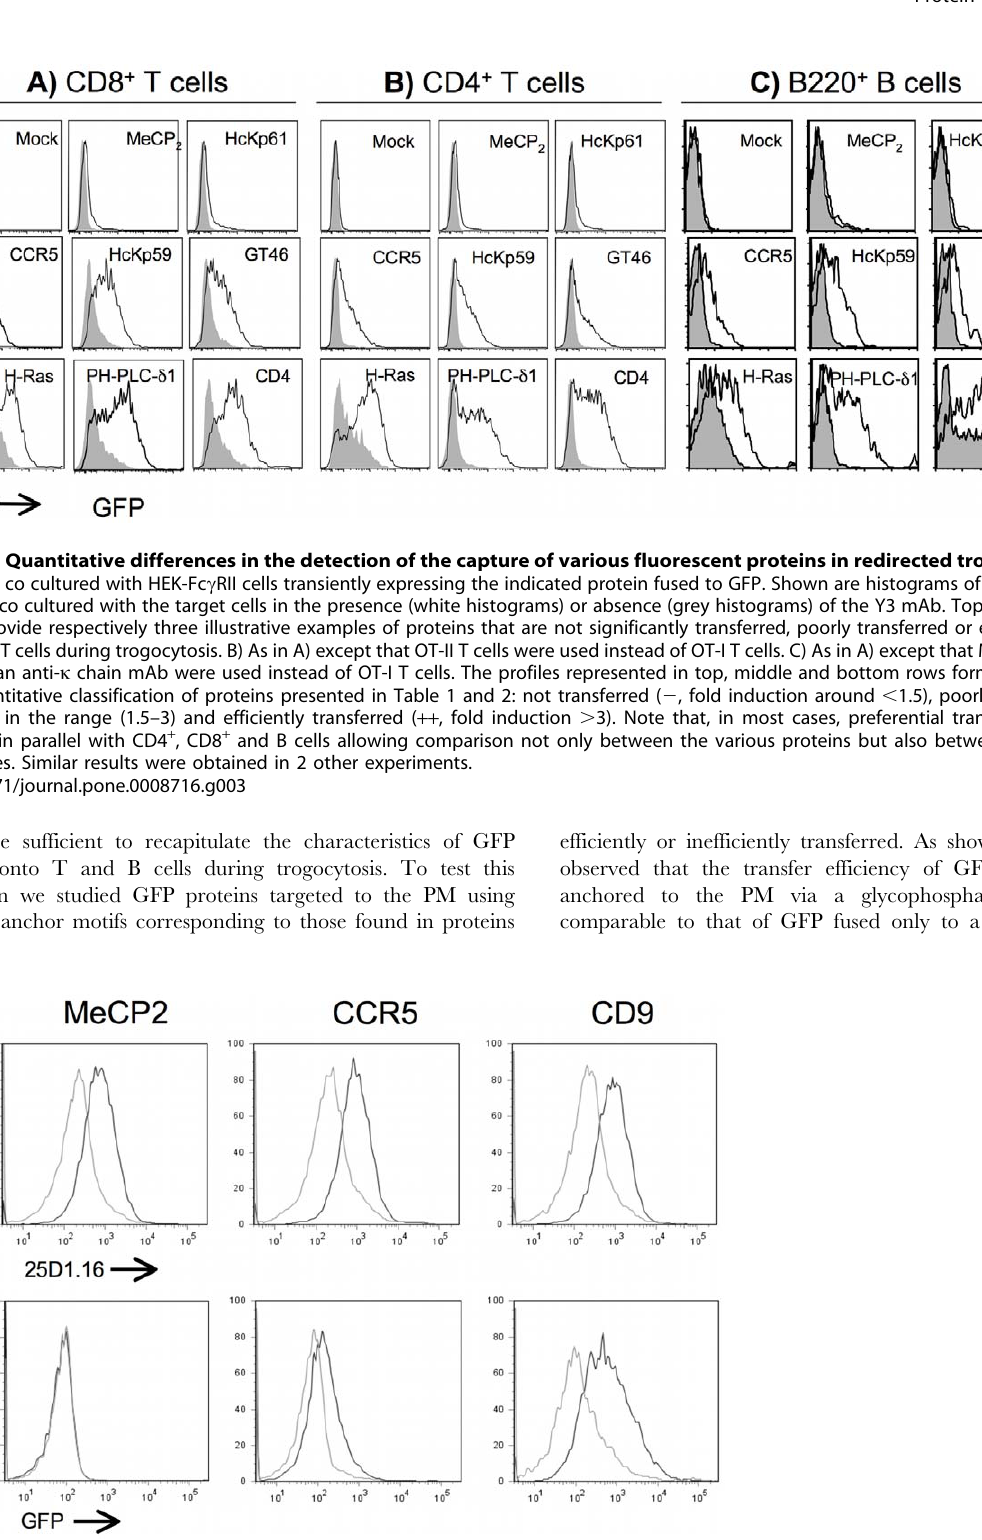
Figure 4. Quantitative differences in the transfer efficiency of various GFP proteins on T or B cells during Ag-mediated trogocytosis. A) OT-I T cells were co cultured with HEK-H-2K b - b 2m-OVA cells that were transiently transfected 48 hours earlier with vectors encoding the indicated protein fused to GFP. The histograms show the capture by OT-I cells of the peptide-MHC complex (recognised by the 25D1.16 mAb), during the co culture with the target cells in the presence (white line) or absence (grey line) of latrunculin B. Left, middle and right panels provide typical examples of the results obtained respectively for proteins not transferred, poorly transferred or efficiently transferred onto OT-I T cells. B) As in A) except that GFP fluorescence was analyzed on gated OT-I T cells. Similar results were obtained for all the constructs shown on Table 1 and 2, and reproduced in 2 independent experiments.